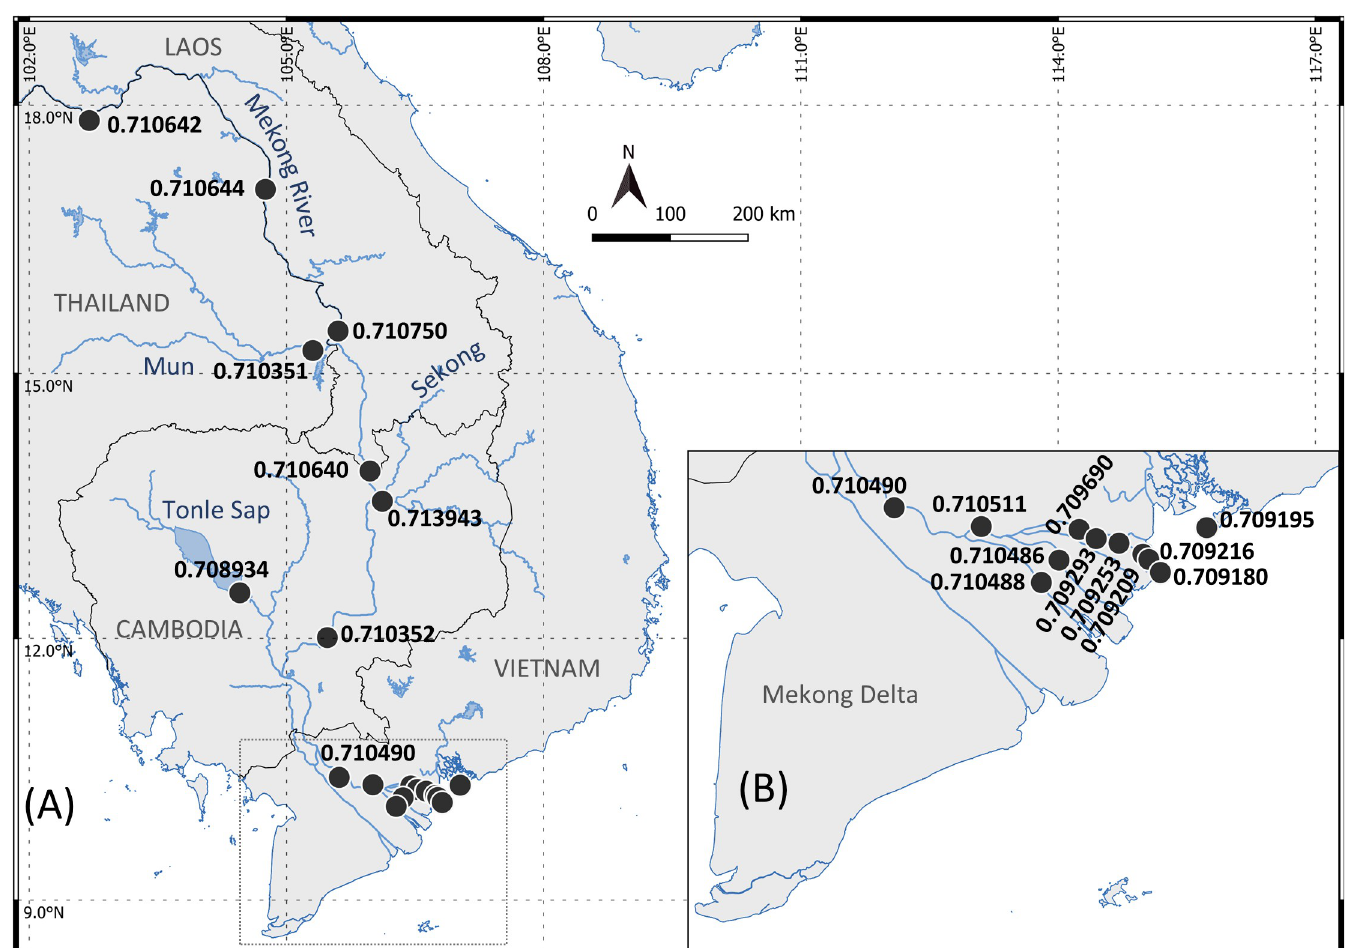
Fig 9. Map of 87 Sr/ 86 Sr values along the Mekong River and tributaries. Detailed values are listed in Table 2.